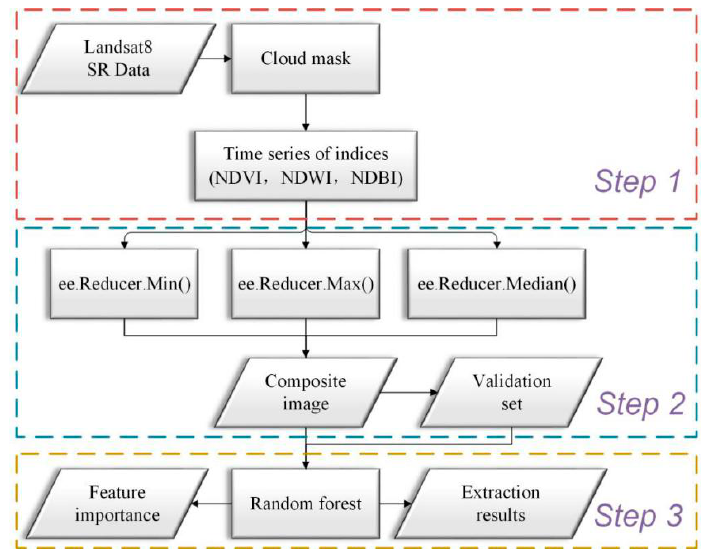
Figure 2. Overall flowchart adopted in this